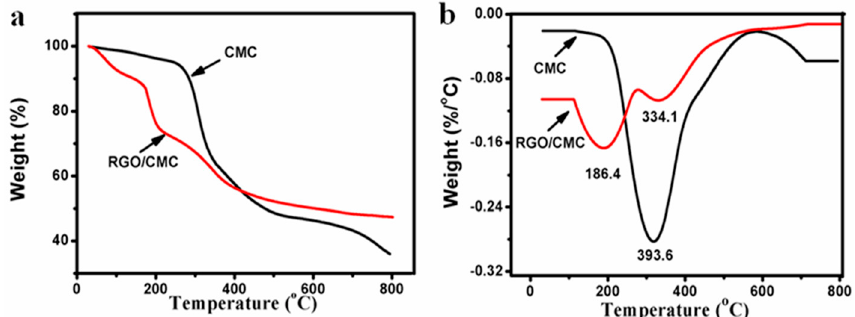
Figure 3. ( a ) TG and ( b ) DTG curves of CMC and